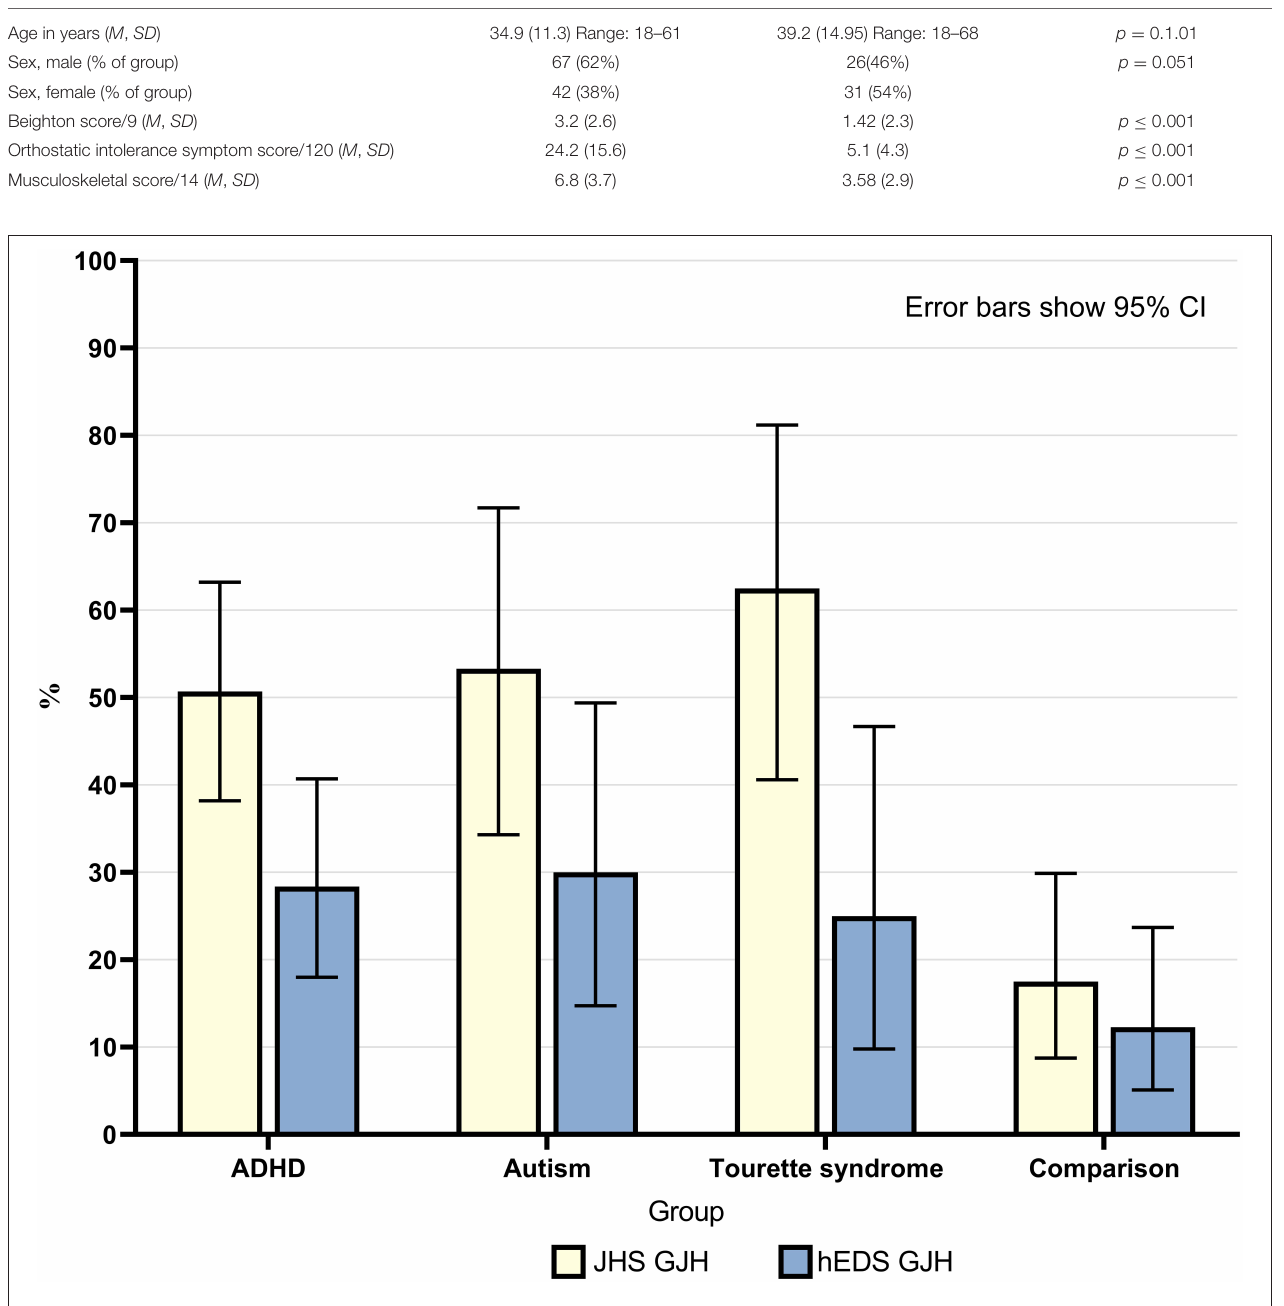
samples and considered significant if the bootstrapped confidence intervals do not cross zero. For these analyses the predictor variable was neurodivergence, the mediator variable was Beighton Score, and the outcome variables